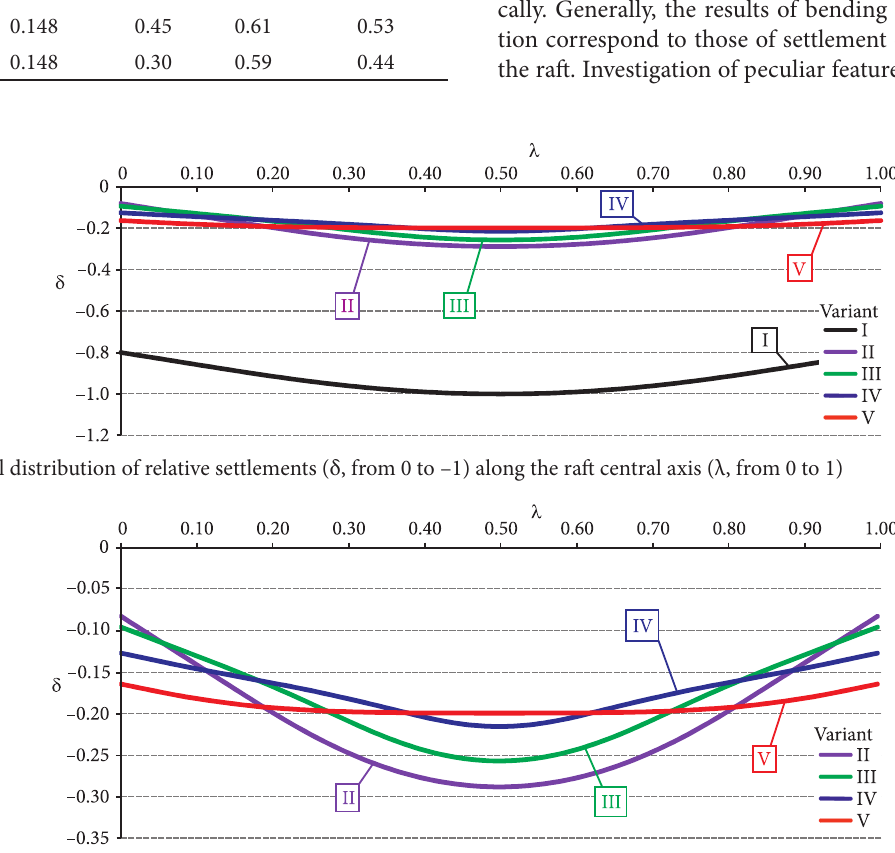
fig. 9. Detailed distribution of relative settlements (δ, from 0 to –1) along the raft central axis (λ, from 0 to